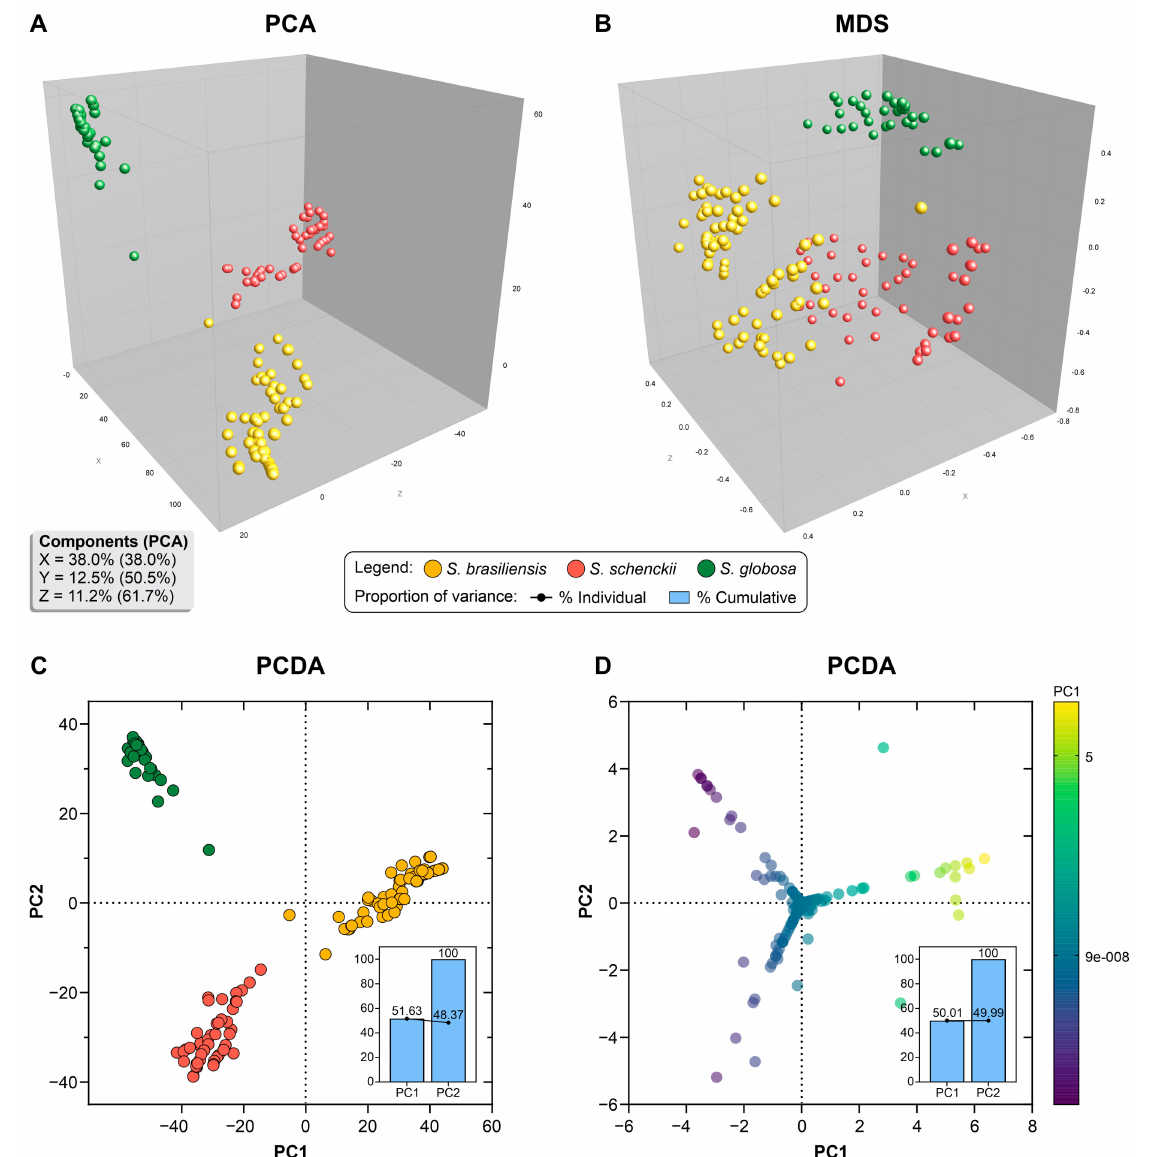
Figure 8. Dimensionality reduction using principal component analysis (PCA), multidimensional scaling (MDS), and principal component discriminant analysis (PCDA) of the SSR markers: ( A ) PCA of 180 Sporothrix isolates shows that the first three components explain 61.7%; ( B ) MDS analysis of 180 Sporothrix isolates; ( C ) PCDA analysis of 180 Sporothrix isolates splits S. brasiliensis , S. schenckii, and S. globosa into three different clusters; ( D ) PCDA analysis of SSR alleles reveals the best discriminating components for Sporothrix groups. Dimensionality reduction analyses were created in the software BioNumerics